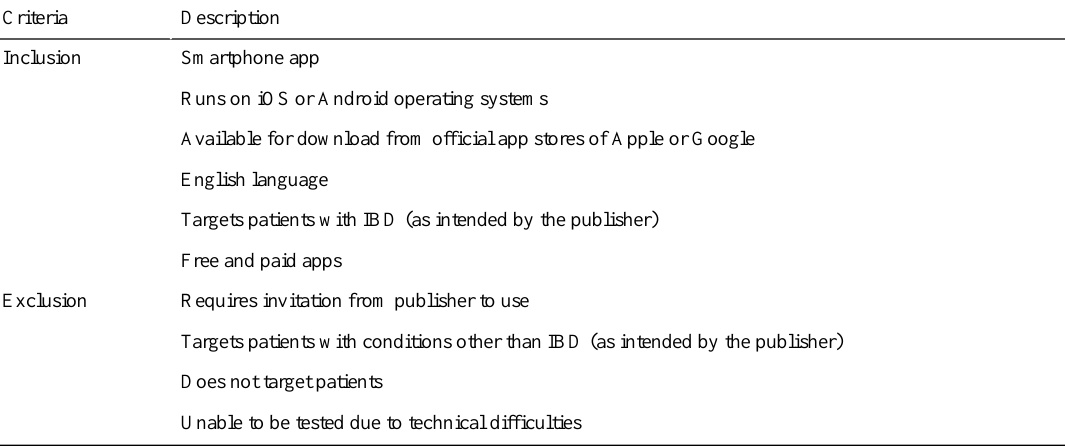
Table 1. Systematic search